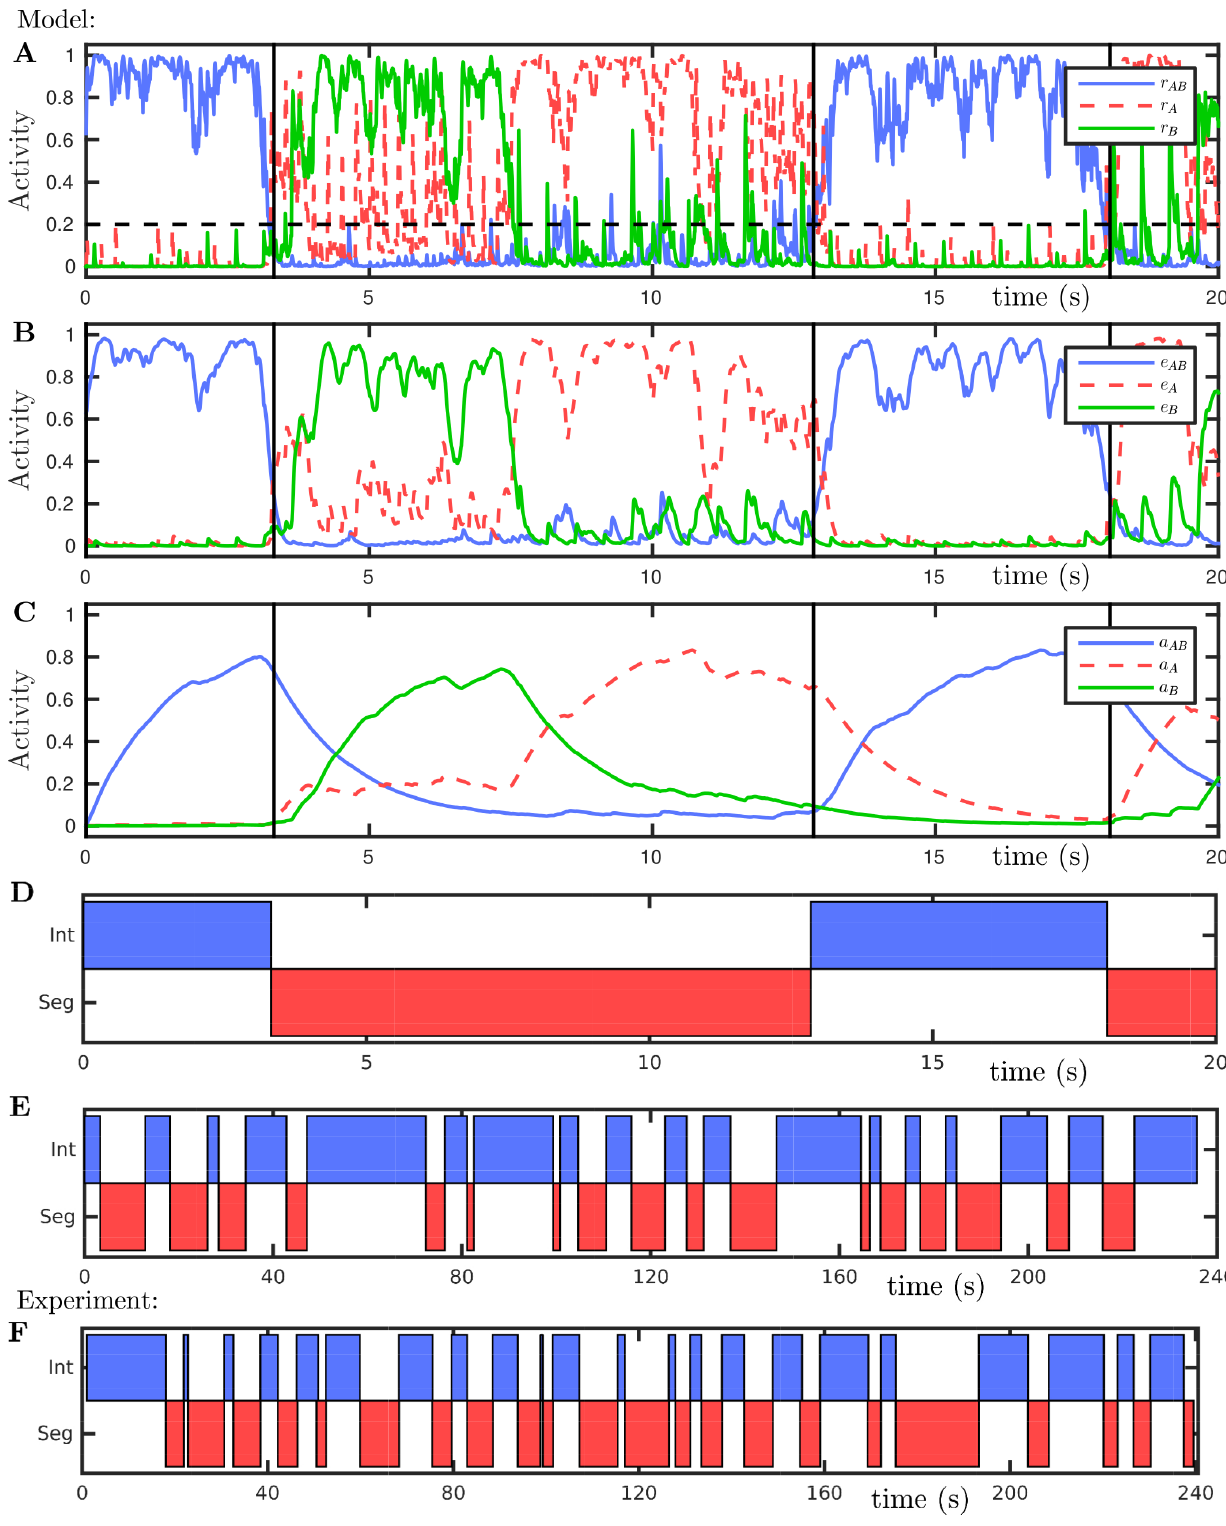
Fig 4. Time courses of model responses (A – C), predicted percepts (D – E), and an example of perceptual reports from our psychoacoustic experiments (F). A : Population firing rate time courses with Δ f = 5 st and PR = 8 Hz. The firing rate function threshold θ F is a horizontal dashed black